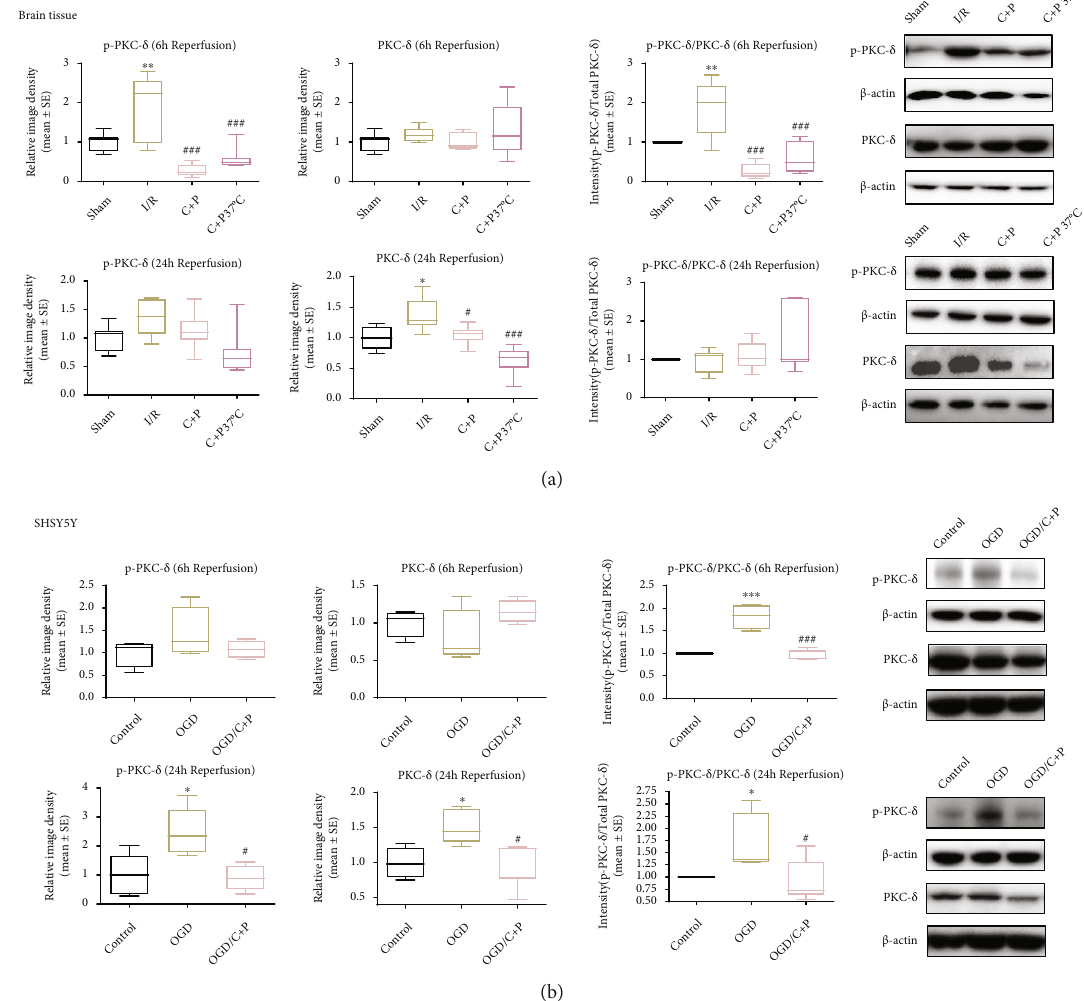
Figure 5: C+P decreased activation of PKC- δ induced by cerebral ischemia or OGD/R. (a) Representative bands of phosphorylated and total protein expressions of PKC- δ in brain tissue identi fi ed via Western blot at 6 and 24 hours of reperfusion. β -Actin served as an internal control. Bar graphs demonstrate semiquantitative levels of PKC- δ , identi fi ed using band density analysis. MCAO enhanced PKC- δ phosphorylation. C+P treatment reduced PKC- δ phosphorylation as compared with the stroke group at 6 hours of reperfusion. Total PKC- δ protein expression increased, but C+P reduced its level at 24 hours of reperfusion. Moreover, the ratio of p-PKC- δ /PKC- δ signi fi cantly increased post-MCAO but decreased with C+P treatment at 6 hours of reperfusion ( n = 7 ). ∗ p < 0 : 05 , ∗∗ p < 0 : 01 versus the sham group; # p < 0 : 05 , ### p < 0 : 001 versus the I/R group. Results are presented as mean ± SE . (b) Representative bands of both phosphorylated and total PKC- δ levels in SHSY5Y cells identi fi ed via Western blot at 6 and 24 hours of reoxygenation. β -Actin served as an internal control. Bar graphs display semiquantitative levels of PKC- δ as determined by band density analysis. The p-PKC- δ /PKC- δ ratio was signi fi cantly higher after OGD/R; however, it decreased after C+P administration at 6 hours of reoxygenation. Furthermore, both PKC- δ phosphorylation and the total levels of PKC- δ were signi fi cantly higher after OGD/R; however, C+P annulled this trend at 24 hours of reoxygenation. Similarly, OGD/R facilitated the raise in the p-PKC- δ /PKC- δ ratio, but C+P decreased this trend at 24 hours of reoxygenation. ∗ p < 0 : 05 , ∗∗∗ p < 0 : 001 versus the OGD group; # p < 0 : 05 , ### p < 0 : 001 versus the OGD/C+P group. Results are shown as mean ± SE of three independent